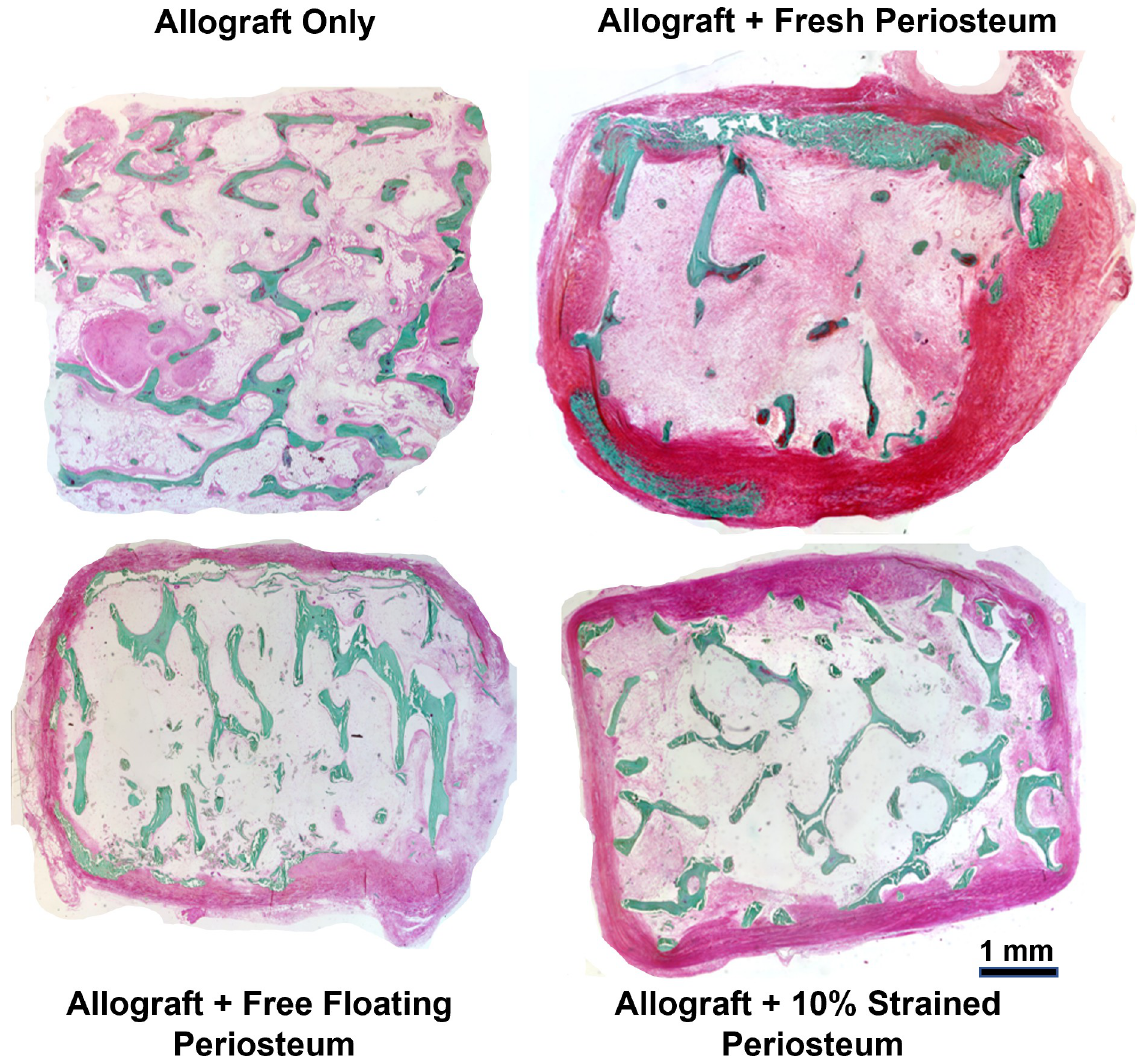
Fig 5. Mineralization in bone allograft following subcutaneous implantation. Masson-Goldner staining of undecalcified sections from allograft only, allograft wrapped with fresh periosteum and allograft wrapped with mechanically expanded periosteum 16 weeks post-